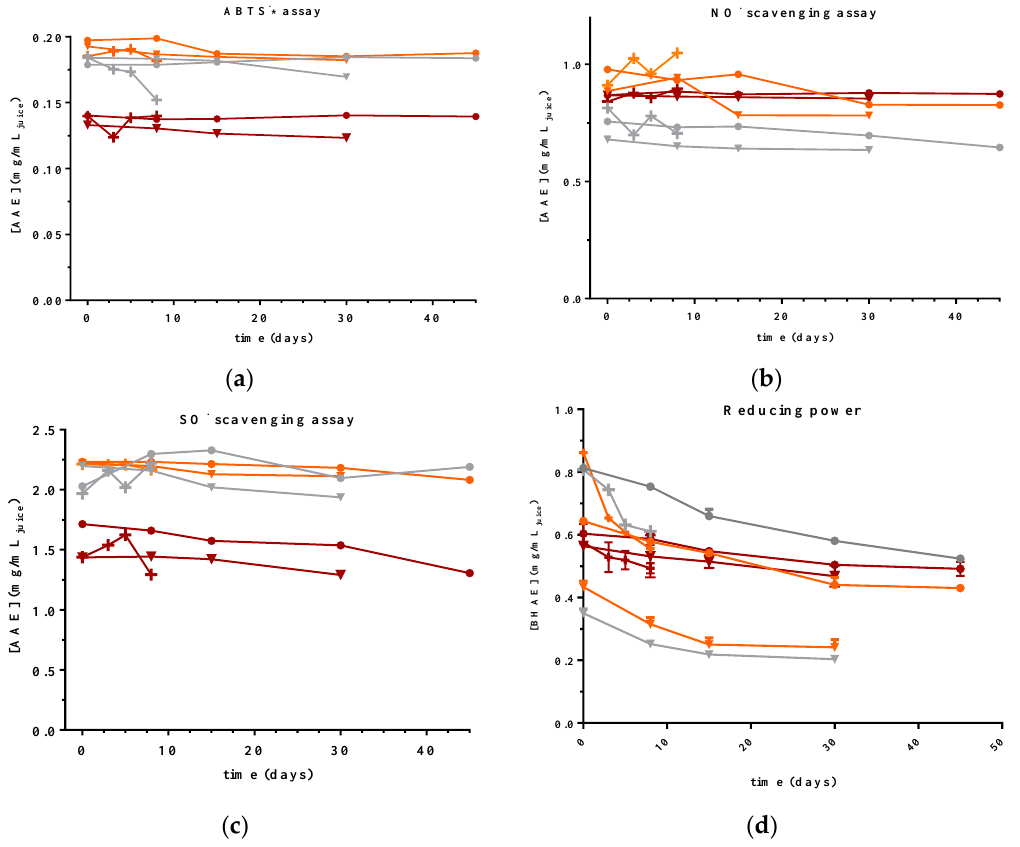
Figure 6. Variation in the antioxidant capacity of Opuntia juices presented in gallic acid equivalents and given by the ( a ) ABTS •+ , ( b ) NO • , ( c ) SO • and ( d ) reducing power assays over storage time in Figure 2 . Evaluation of the ( a ) pH and ( b ) titratable acidity in juices of O. ficus-indica versus storage Figure 2 . Evaluation of the ( a ) pH and ( b ) titratable acidity in juices of O. ficus-indica versus storage Figure 2 . Evaluation of the ( a ) pH and ( b ) titratable acidity in juices of O. ficus-indica versus storage prickly pear non-pasteurized samples (raw (+)) and the two processing methods (high-pressure pro- time for non-pasteurized samples (raw ( □ )) and the two processing methods (high-pressure time for non-pasteurized samples (raw ( □ )) and the two processing methods (high-pressure time for non-pasteurized samples (raw ( □ )) and the two processing methods (high-pressure cessing (●) and th ermal pasteurization ( ▼ )). Cv ´Rossa´ (red juice) in red ( ▬ ), cv ‘ Gialla ’ (orange processing ( ● ) and thermal pasteurization ( ▼ )). Cv ´Rossa´ (red juice) in red ( ▬ ), cv ‘Gialla’ (orange processing ( ● ) and thermal pasteurization ( ▼ )). Cv ´Rossa´ (red juice) in red ( ▬ ), cv ‘Gialla’ (orange processing ( ● ) and thermal pasteurization ( ▼ )). Cv ´Rossa´ (red juice) in red ( ▬ ), cv ‘Gialla’ (orange juice) in orange ( ▬ ), and cv ‘ Bianca ’ (white juice) in gray ( ▬ ). Results are expressed as averages ± SD. juice) in orange, ( ▬ ) and cv ‘Bianca’ (white juice) in gray ( ▬ ). Results are expressed as averages ± SD. juice) in orange, ( ▬ ) and cv ‘Bianca’ (white juice) in gray ( ▬ ). Results are expressed as averages ± SD. juice) in orange, ( ▬ ) and cv ‘Bianca’ (white juice) in gray ( ▬ ). Results are expressed as averages ±